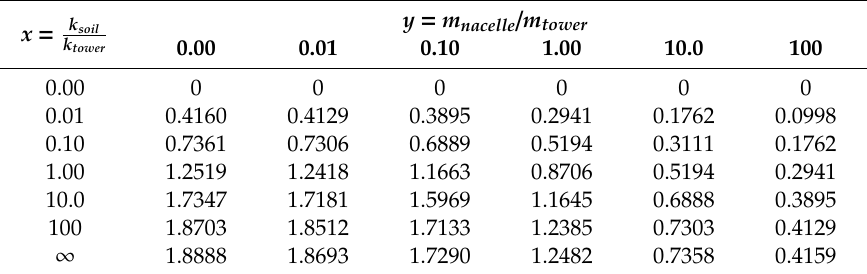
Table 3. Characteristic values of λ